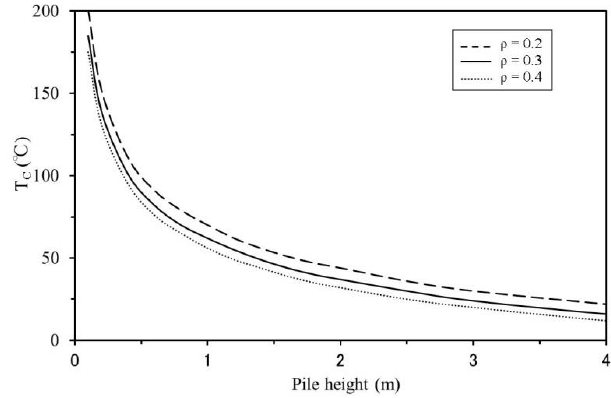
Figure 23. Frank-Kamenetskii results for SSSR. Recycling 2018 , 3 , x